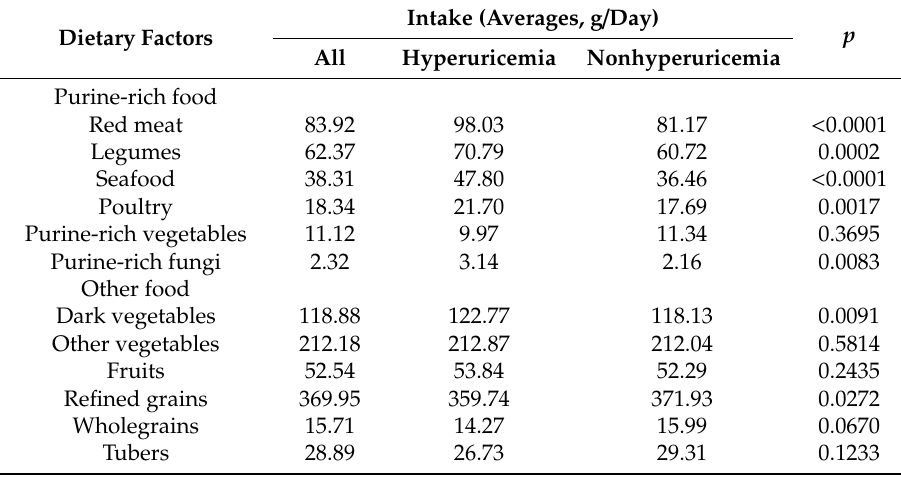
Table 2. Food intake of hyperuricemia group and nonhyperuricemia group ( n =